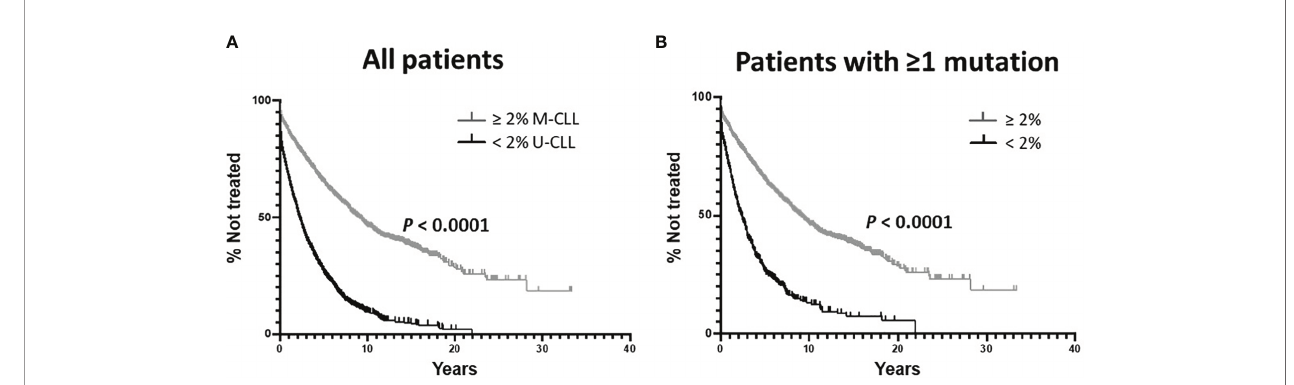
FIGURE 1 | Kaplan-Meier estimates of time to fi rst treatment (TTFT) using the classical IGHV-mutation status parameters. (A) Comparison of TTFT based on the < 2% vs. ≥ 2% difference from the germline IGHV sequence. All 3,598 sequences were used without regard for the types of somatic IGHV mutations. M-CLL: 1,885 patients, 856 treated; U-CLL: 1,713 patients, 1,369 treated. Data analyzed using the Log-rank (Mantel-Cox) test. (B) Comparison of TTFT based on the < 2% vs. ≥ 2% difference from the germline IGHV sequence analyzing only those patients with ≥ 1 IGHV mutation. < 2%: 454 patients, 351 treated; ≥ 2% 1,885 patients, 856 treated.